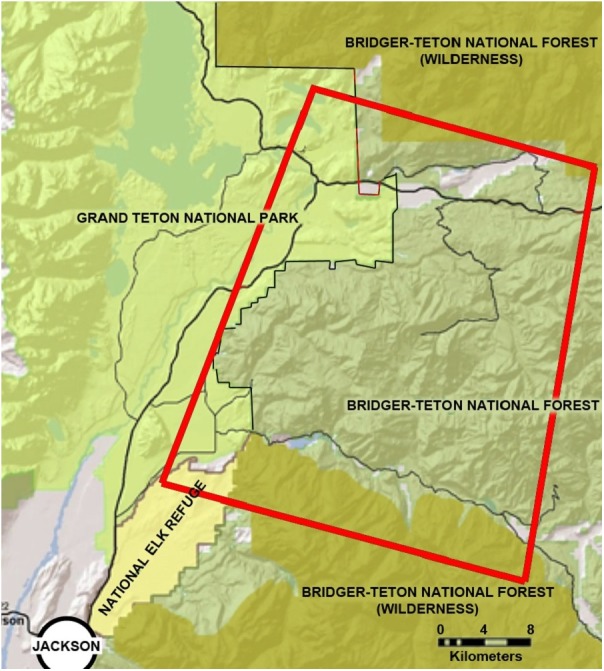
The location of the study area in northwestern Wyoming, USA.The study area is located northeast of the city of Jackson, Wyoming, and is delineated in this figure by a red line. It encompasses sections of the National Elk Refuge, Grand Teton National Park, and Bridger-Teton National Forest.